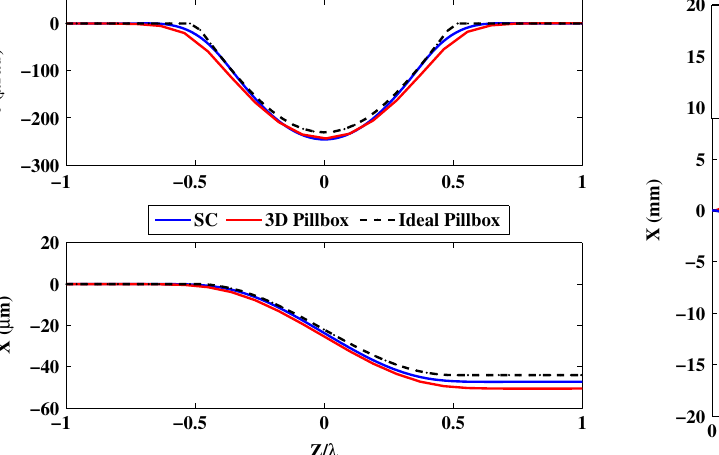
FIG. 10. Evolution of vertical displacement corresponding to the rf phases (cid:4) A;B;C and deflecting voltage V def ¼ 5 : 05 MV .